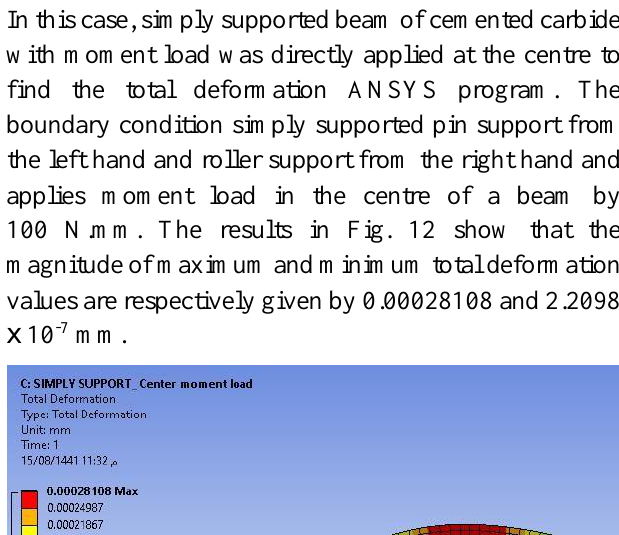
Fig. 9. Total deformation of 2.9 mm (max.) of cemented carbide, simply supported beam with load at the midpoint of the span